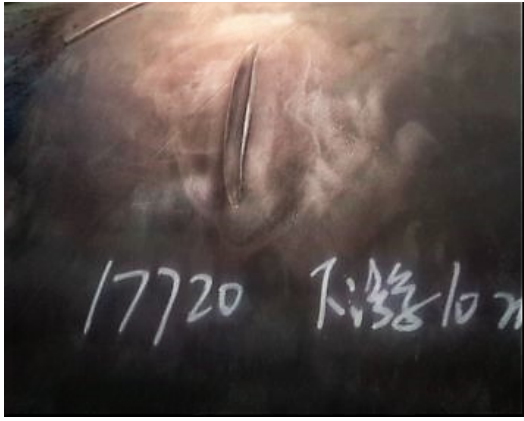
Figure 14. Picture of gouge in GW 17720 base metal.